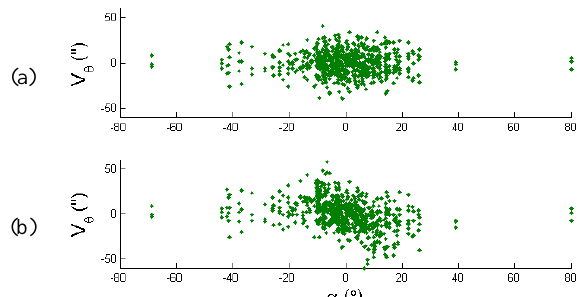
Figure 11: (a) Horizontal angle residuals versus vertical angle plot in point-based self-calibration for hybrid scanners without systematic errors. (b) Unmodelled 1’ trunnion axis error.